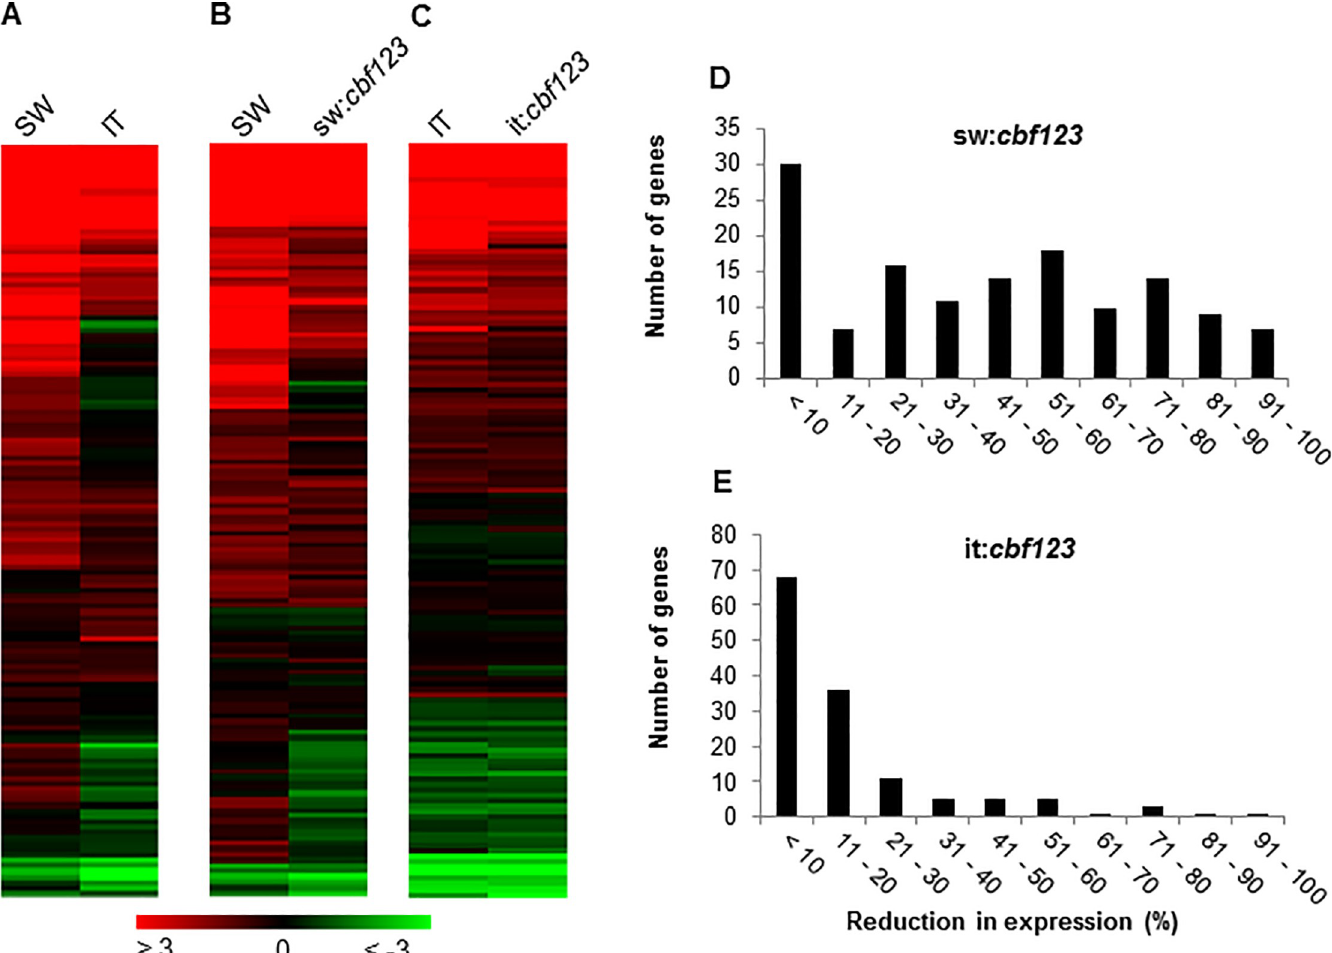
Fig 4. Inactivation of the CBF pathway in the SW and IT ecotypes impairs long-term induction of CBF regulon genes. (A, B, C) Transcript levels for the 136 CBF regulon genes of Arabidopsis Ws-2 [14] were compared between (A) IT and SW, (B) SW and sw: cbf123 , and (C) IT and it: cbf123 plants after exposure to 4˚C for 2 weeks. Heat maps represent log 2 fold-change. (D, E) Histogram showing the number of CBF2 regulon genes that were reduced in expression at low temperature (4˚C for 2 weeks) in the cbf123 triple mutants compared with their respective WT plants.